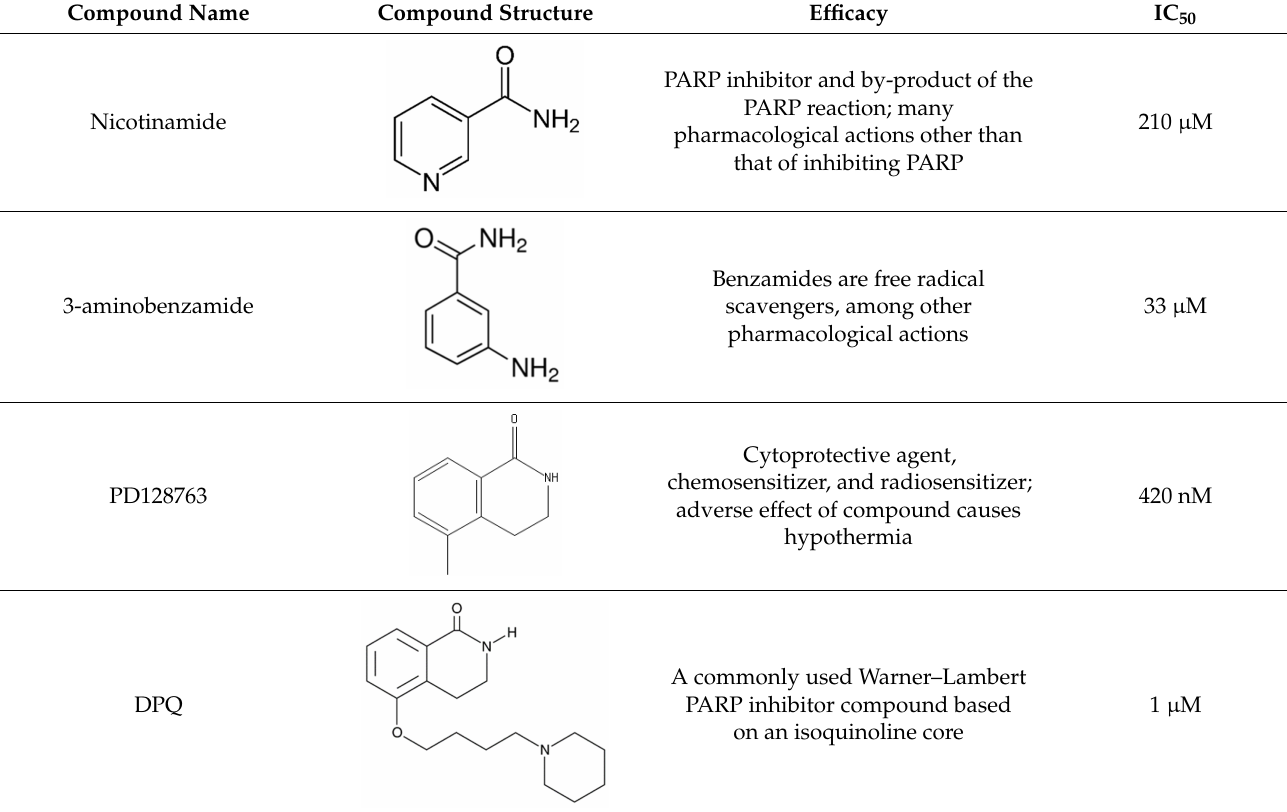
Table 1. List of PARP